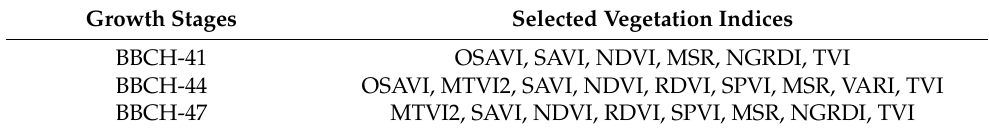
Table 6. Remaining VIs after removing highly correlated variables for each growth stage.